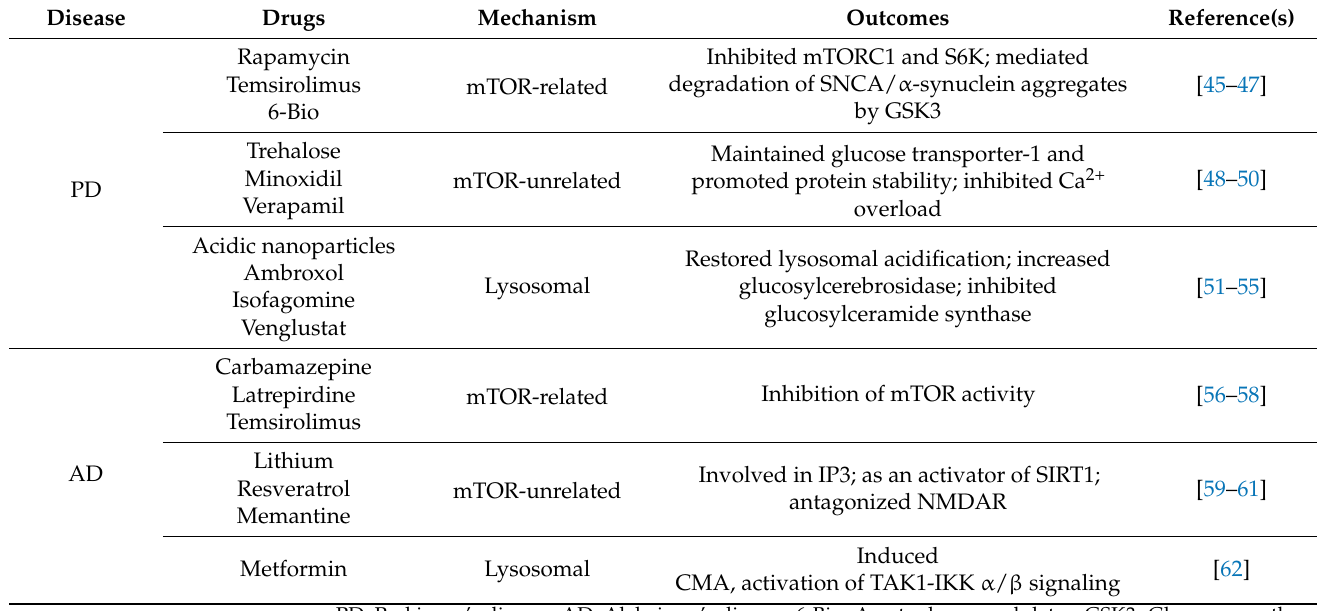
Table 2. Treatment of neurodegenerative diseases targeting the lysosomal pathway.